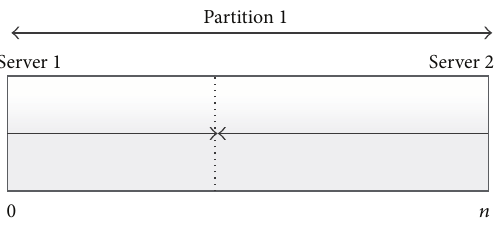
Figure 4: Download directions of two cloud